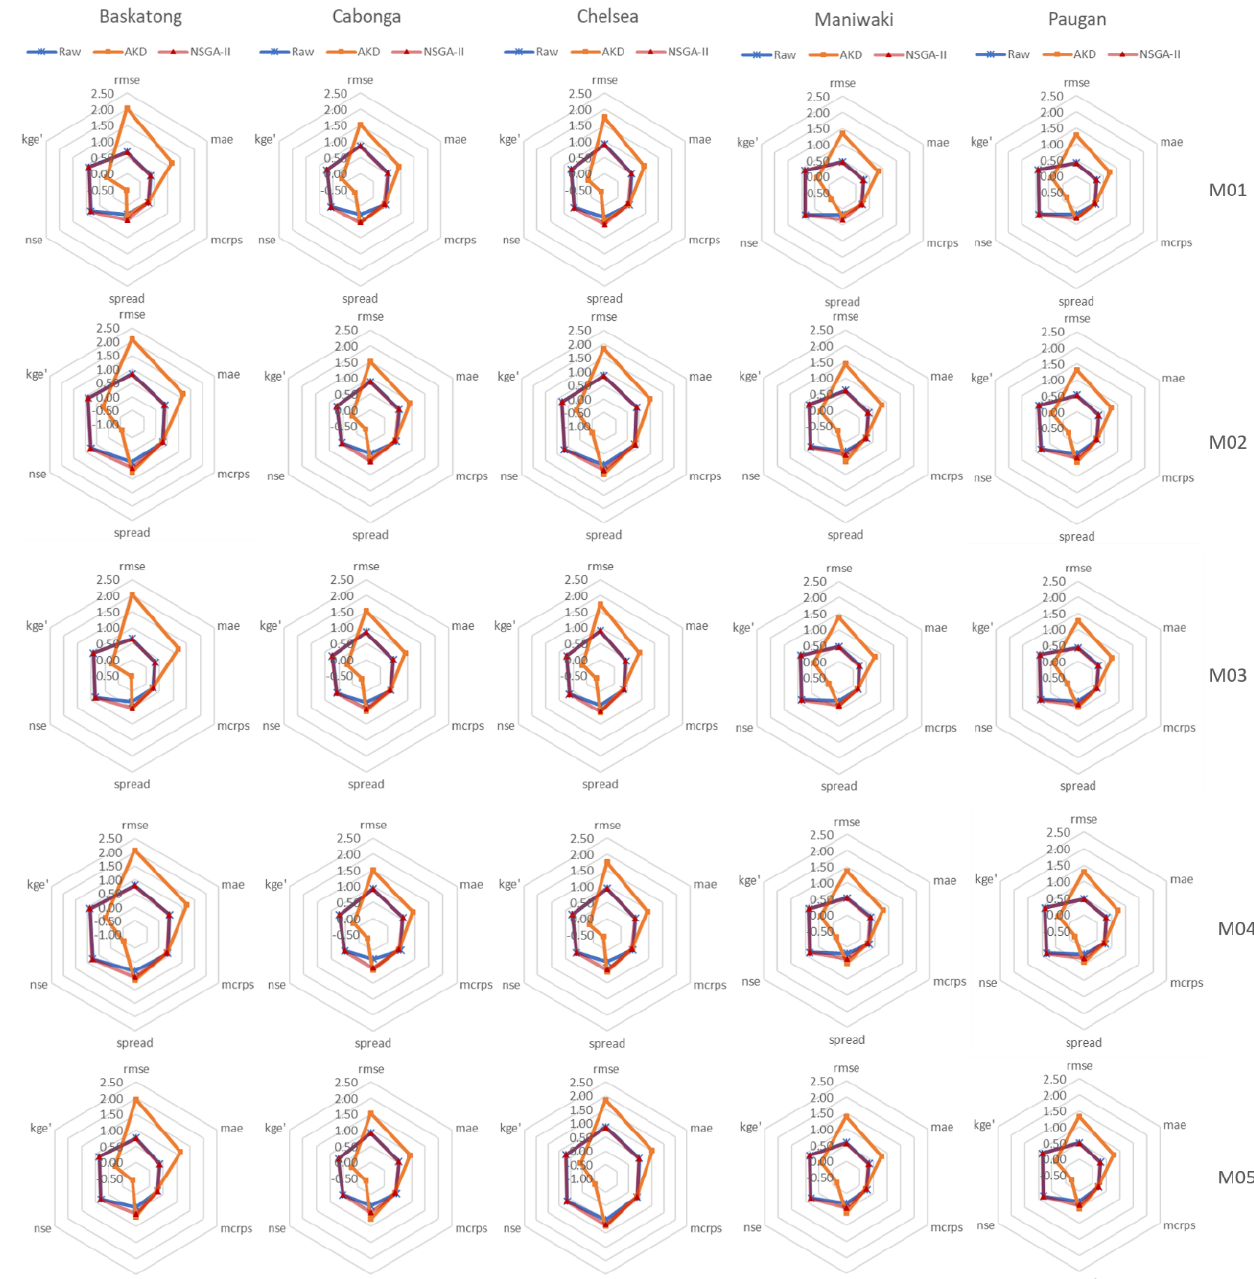
Figure 8. Accuracy performance assessment of the raw, AKD, and NSGA-II forecasts (4d ahead forecast) for five single-model H-EPSs over each sub-catchment of the Gatineau catchment (January 2011–December 2016).